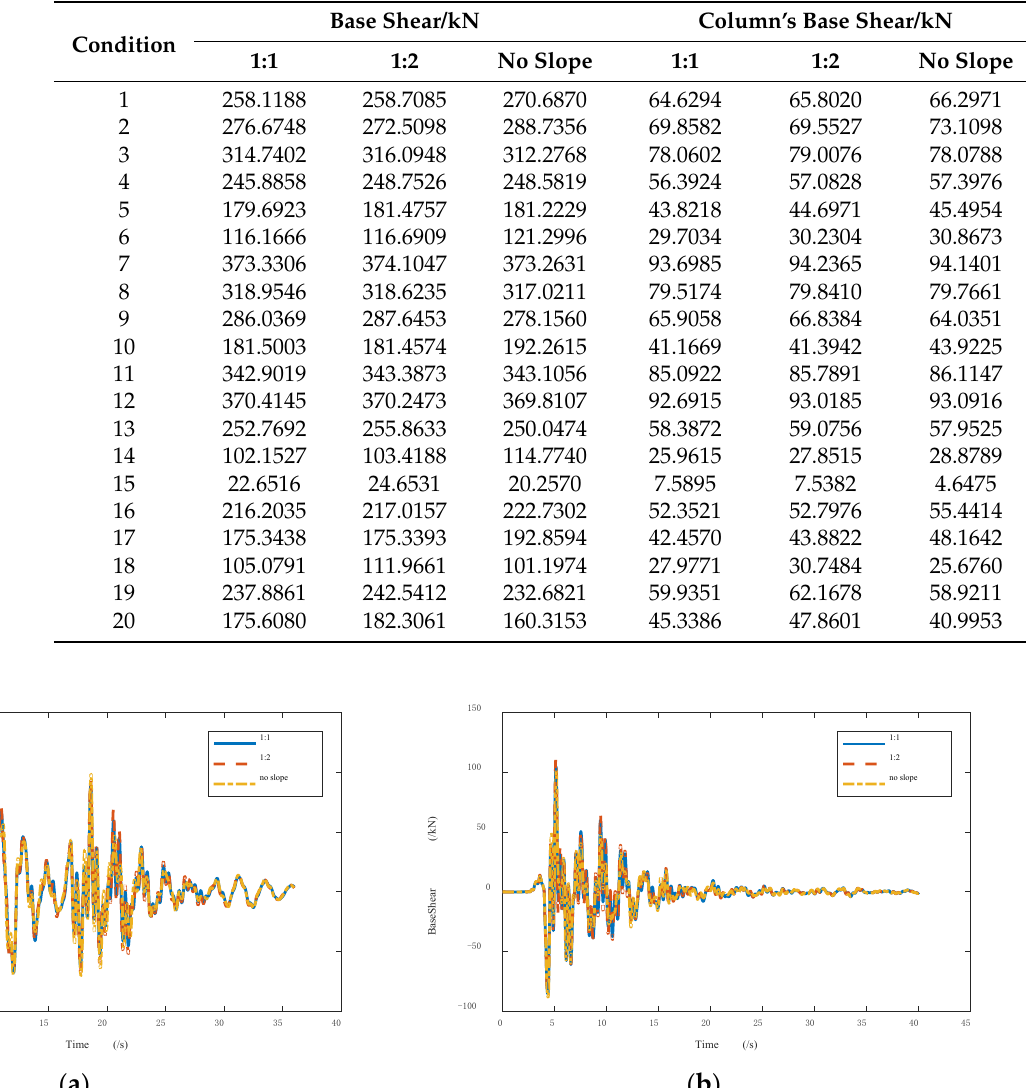
The plots in Figures 12 and 13, respectively, show the base shear and column bottom shear (leftmost column) of the three structures at each time under two different seismic waves. Figure 14 shows the base shear–top floor displacement curve. It can be seen from the figures that, under the action of seismic waves, the existence of the slope had a slight impact on the base shear. Similarly, the slope hardly affected the column bottom shear force, yet the shear at the bottom of the column had a positive X trend at the initial stage. This effect is more obvious with the increase of the slope rate. After the initial phase, the impact of the slope on the shear at the bottom of the column and the shear at the base were very small, which can be almost ignored. Table 6. Peak value of base shear and column bottom shear.